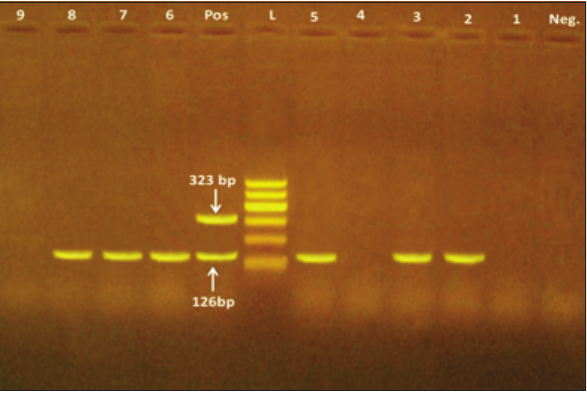
Figure-1: Multiplex-polymerase chain reaction of Campylobacter jejuni and Campylobacter coli strains isolates from raw milk, Kareish cheese and yoghurt samples. Lane (POS): Positive control. Lane (Neg): Negative control. Lane (L): 100 bp ladder as DNA marker. Lanes 2, 3, 5, 6, 7, 8 are positive for C. jejuni only. Lanes 1, 4, 9 are